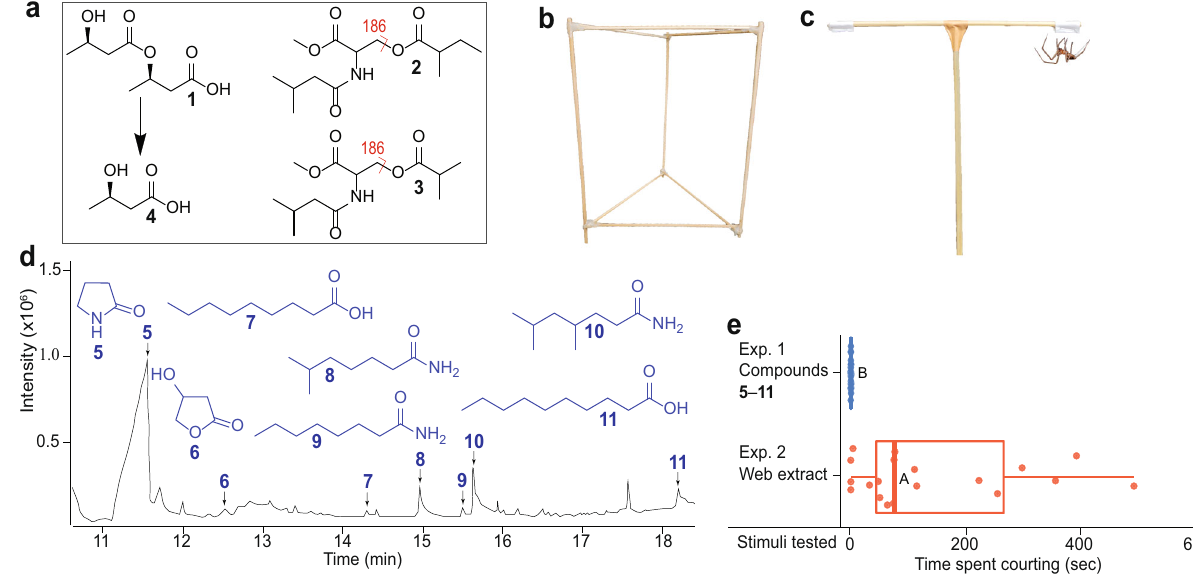
Fig. 1 Known contact pheromone components of spiders and methods to identify analogous components produced by Steatoda grossa females. a Pheromone components of the spiders (i) Linyphia triangularis ([( R )-3-hydroxybutyryloxy-butyric acid ( 1 ) with its breakdown product ( R )-3- hydroxybutyric acid ( 4 )], (ii) Latrodectus hasselti ([ N -3-methyl-butyryl- O -( S )-2-methylbutyryl- L -serine methyl ester ( 2 )], and (iii) Latrodectus hesperus [( N -3-methylbutanoyl- O -methylpropanoyl- L -serine methyl ester ( 3 )]. b Triangular prism scaffold for a female spider to build her web. c T-rod apparatus for testing courtship behaviour by S. grossa males in response to test stimuli (web extract or fractions thereof; synthetic candidate pheromone components; solvent control) applied to a piece of fi lter paper attached to each distal end of the horizontal arm. d Total ion chromatogram of compounds unique to sexually mature S. grossa females (pyrrolidin-2-one ( 5 ), 4-hydroxyhydrofuran-2(3 H )-one ( 6 ), nonanoic acid ( 7 ), dodecanoic acid ( 8 ), 6-methylheptanamide ( 9 ), octanamide ( 10 ), 4,6-dimethyl heptanamide ( 11 ); Supplementary Table 1) identi fi ed by gas chromatography – mass spectrometry of crude female web extract. e Extent of courtship by S. grossa males in response to female web extract or synthetic candidate pheromone components. Circles and boxplots show the time single male spiders courted in each replicate and the distribution of data (minimum, fi rst quartile, median, third quartile, maximum), respectively. Medians with different letters indicate statistically signi fi cant differences in courtship responses. Wilcoxon test, P <